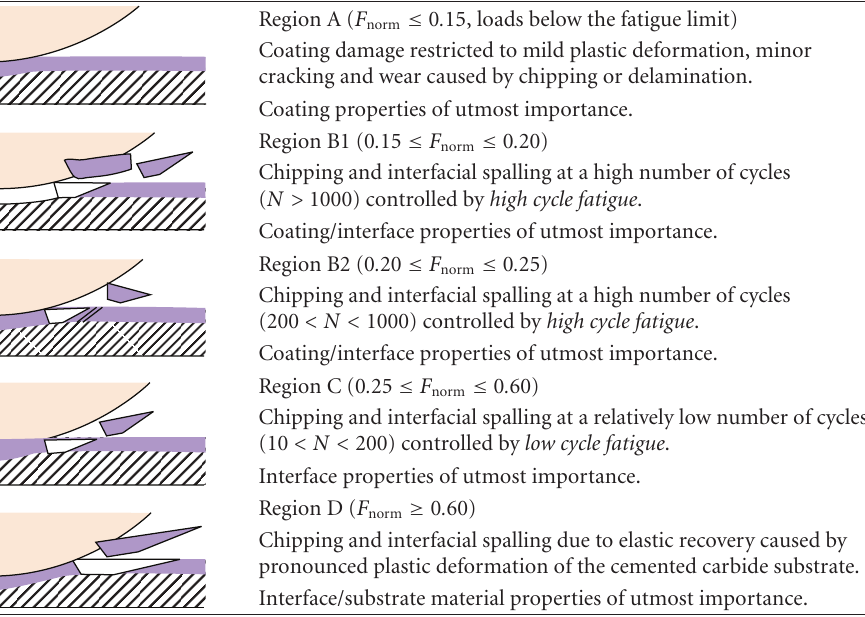
Table 4: Schematic illustrations summarizing the observed coating damage mechanisms during the circular multi-pass scratch testing.